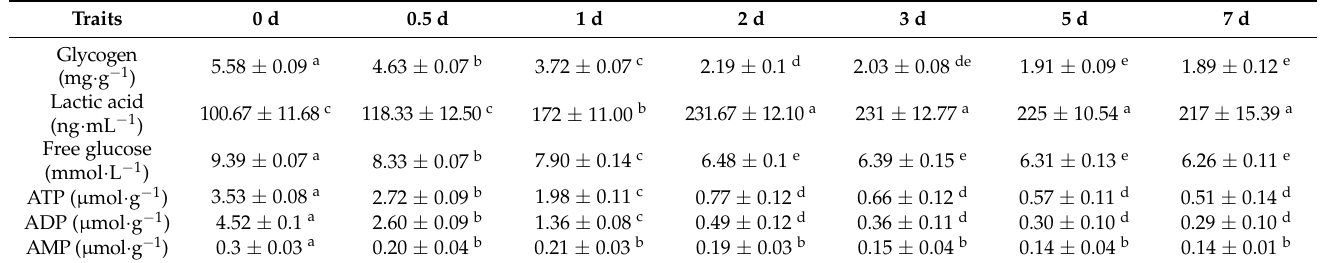
Table 2. Changes in energy metabolism of beef LL muscle during postmortem aging at 4 ◦ C (d 0, 0.5, 1, 2, 3, 5, and